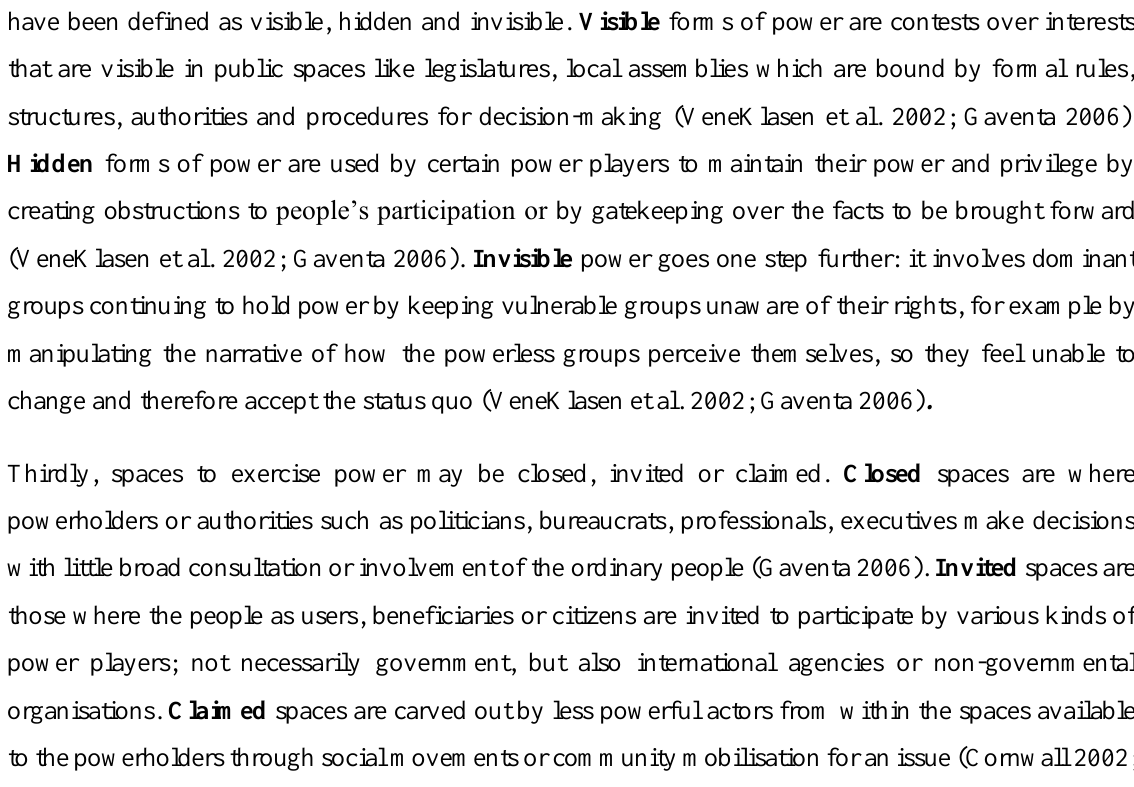
Source: Gaventa (2006, p.